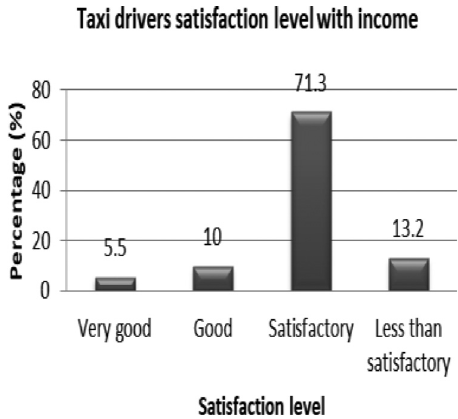
Figure 10. Driver satisfaction